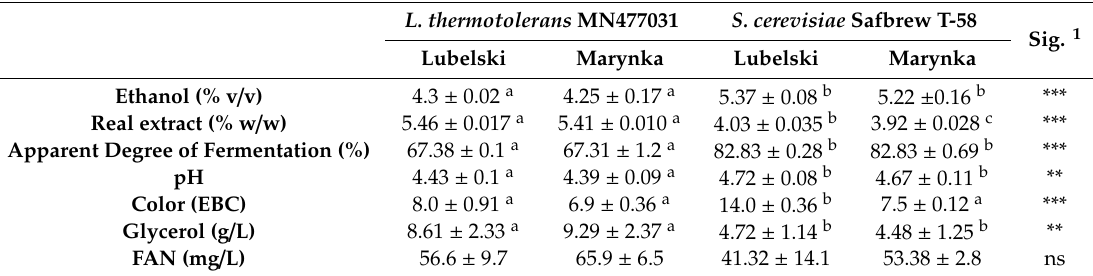
Table 2. Physicochemical parameters of beers depending on the strains and hop